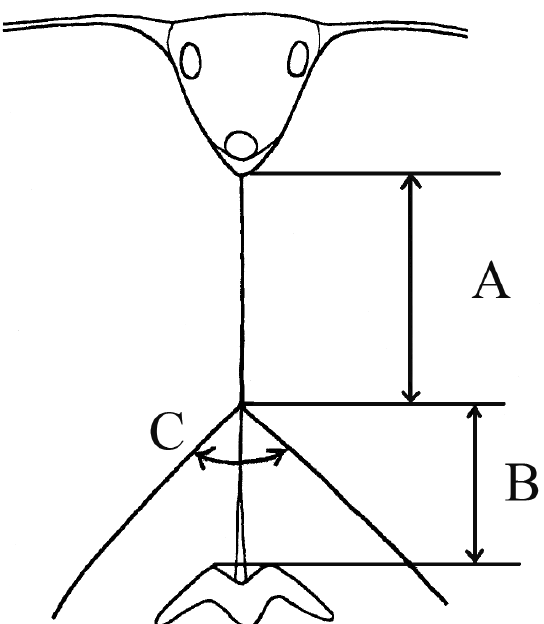
Figure 1. Head of male, dorsal view, comparison of lengths of eye-contiguity ( A ) and frons ( B ), and frontal angle ( C